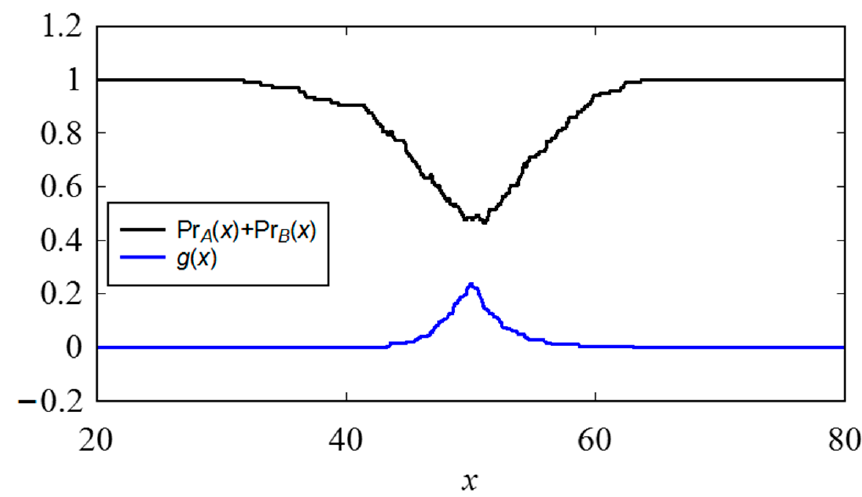
Figure A3. The typical nature of Pr A ( x ) and Pr B ( x ) for unimodal quantity.